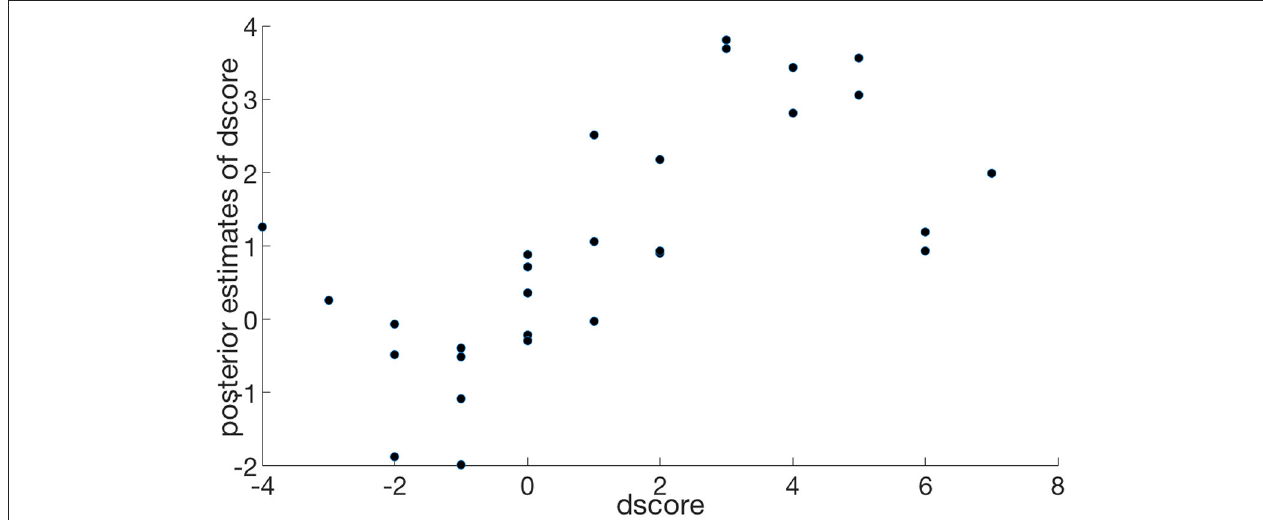
FIGURE 8 | Posterior estimates of dscore by observed dscore , r = 0.66, n =